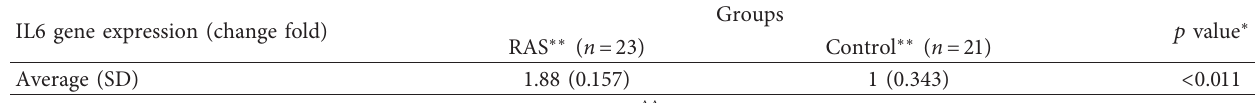
Table 2: Gene expression in the RAS and control group.